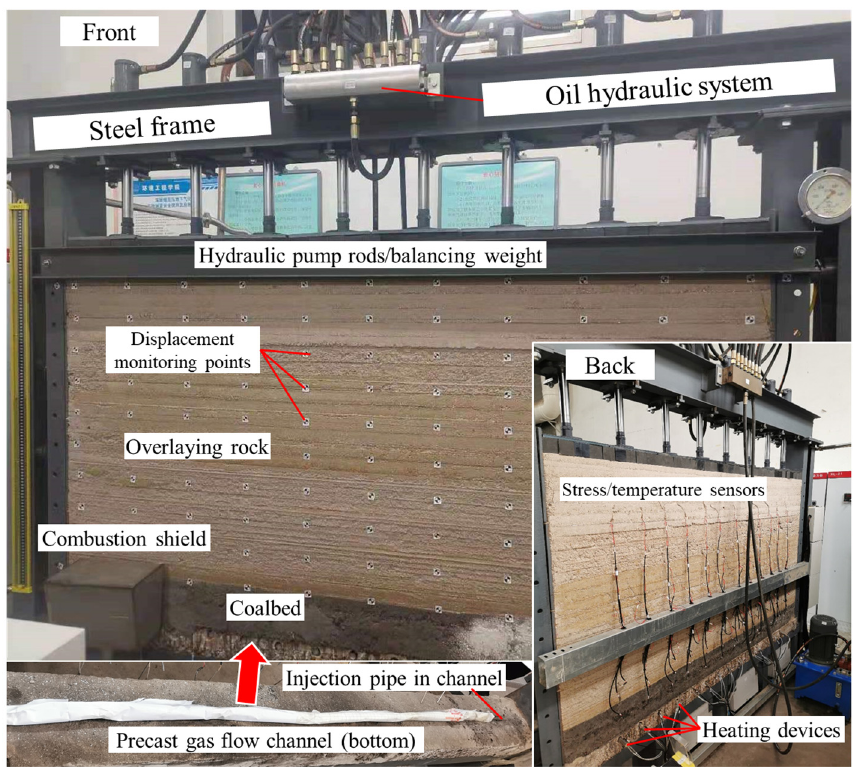
Figure 3. Photos of real devices and experiment preparation (including igniter/heating devices,